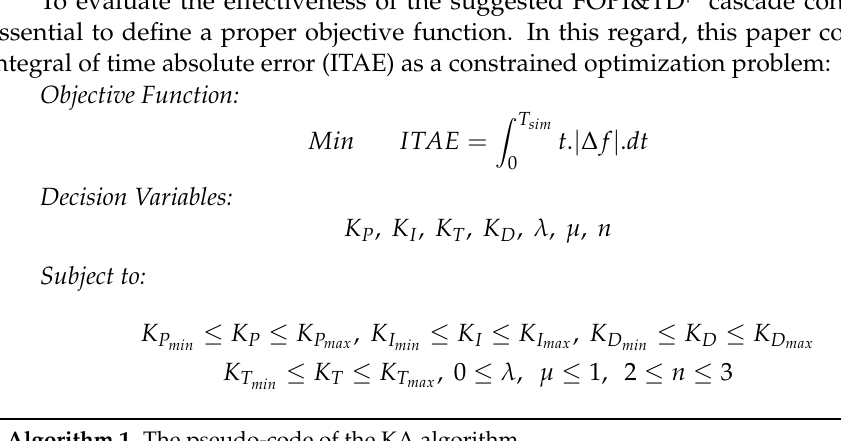
Algorithm 1. The pseudo-code of the KA